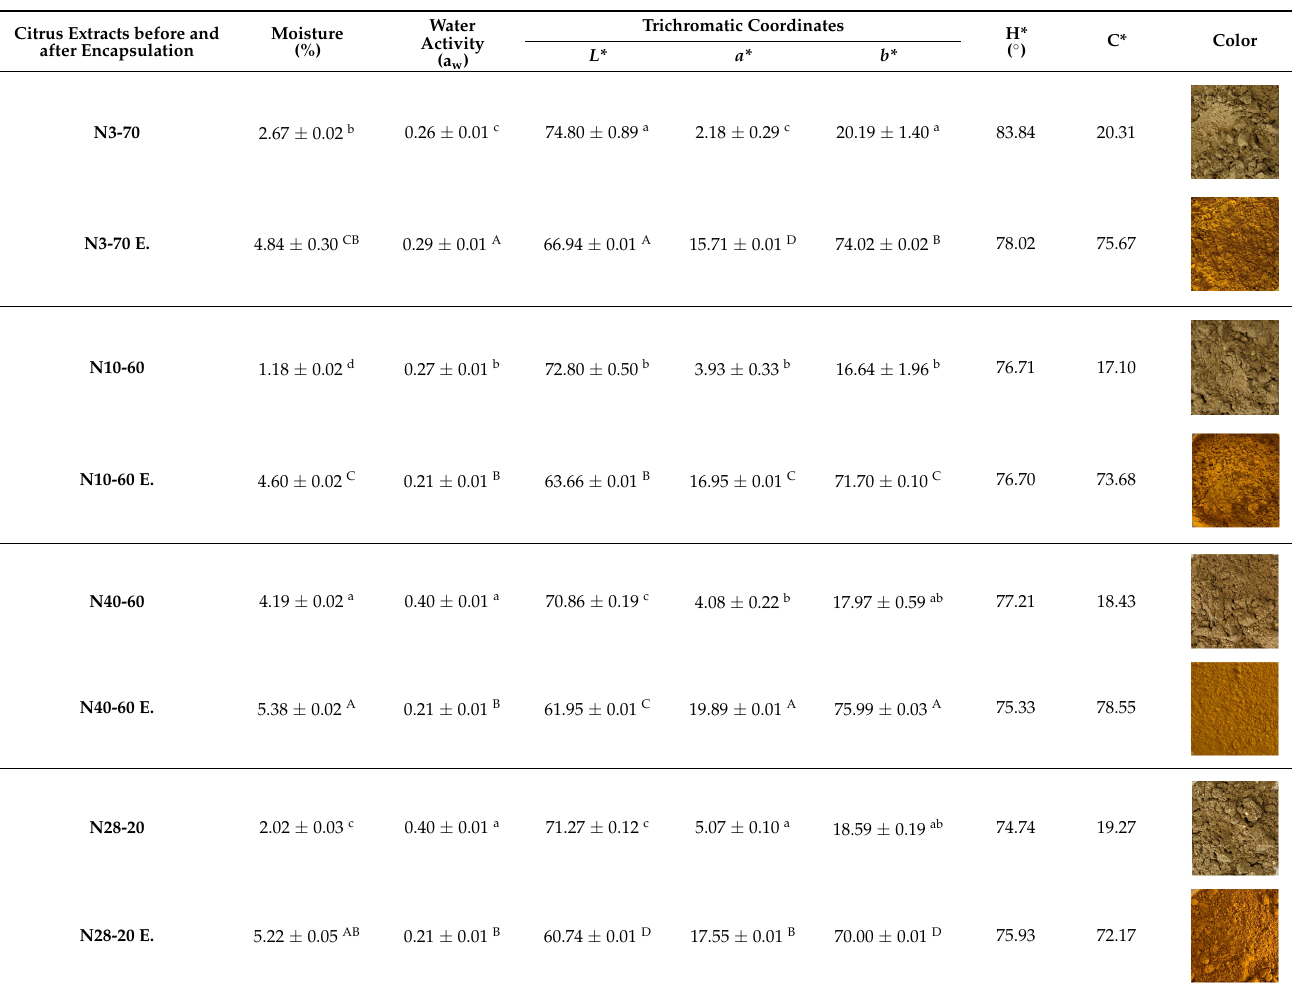
Table 2. The moisture, water activity (a w ), trichromatic coordinates ( L* , a* , and b* ), H* (°) and C* values of the natural extracts and spray ‐ dried encapsulated (E.) extracts. Values reported as mean ± standard deviation. Lowercase letters indicate comparisons between initial commercial extracts, while uppercase letters indicate comparisons between the encapsulated ones. Water Trichromatic Coordinates Activity (a w )